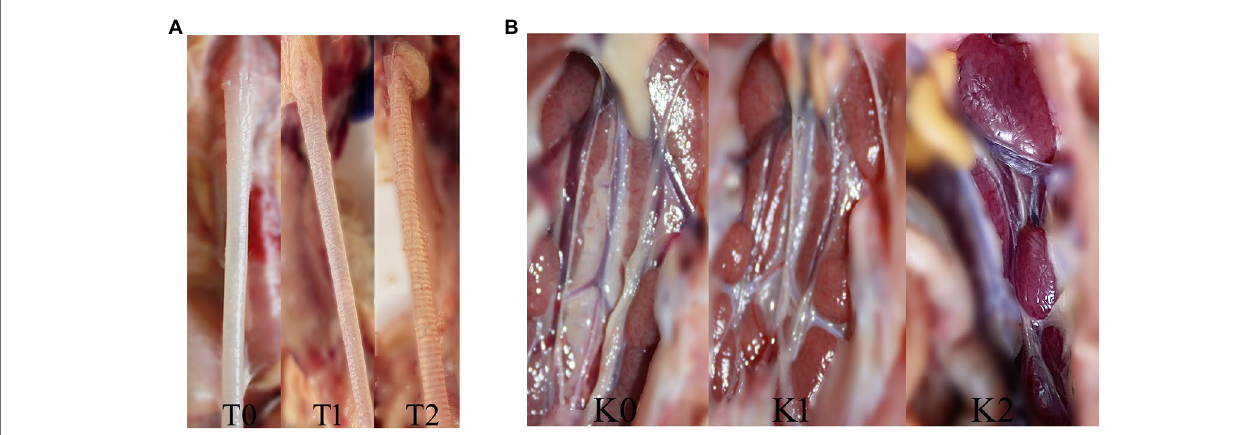
FIGURE 2 | The trachea and kidney lesions in chickens challenged with IBV. (A) The trachea lesion and gross lesion scores: T0 (0 points) for normal, T1 (1 point) for abundant mucus and minor bleeding in the trachea, and T2 (2 points) for large hemorrhage in the trachea. (B) The kidney lesion and gross lesion scores: K0 (0 points) for normal, K1 (1 point) for minor kidney swelling, and K2 (2 points) for visible kidney